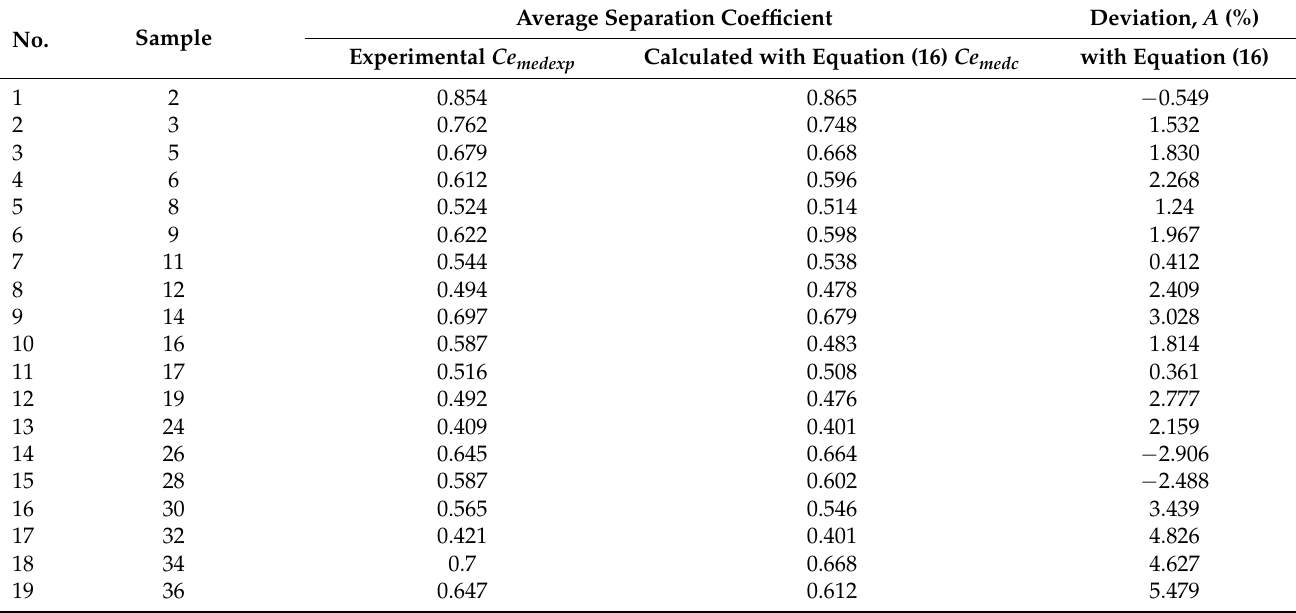
Table 6. Deviations of calculated values compared to the experimentally determined ones (for validation) for average separation coefficient for nettle.